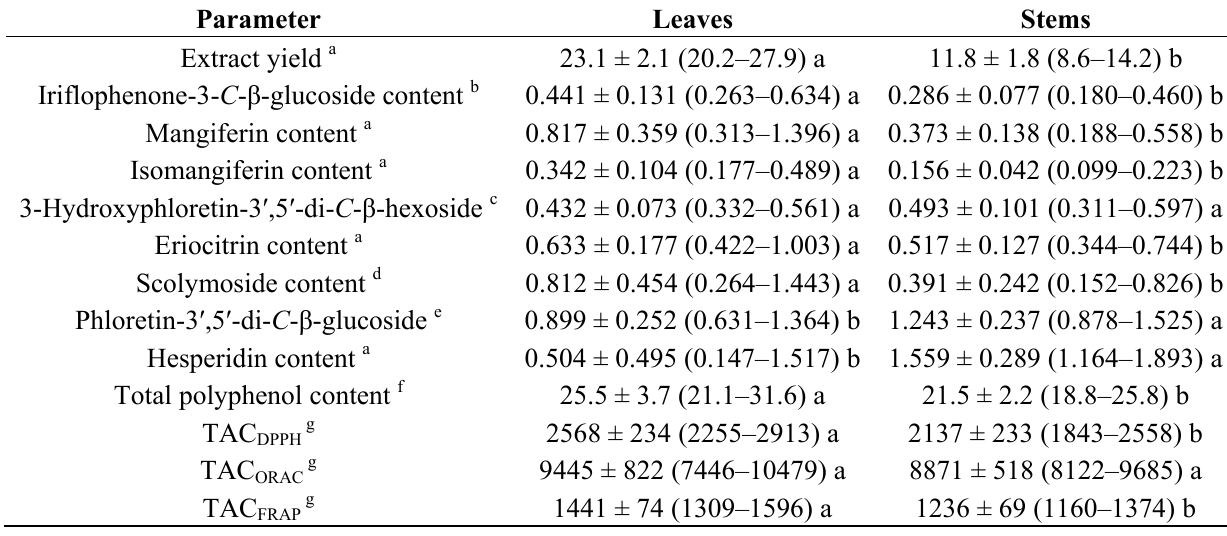
Table 6. Extract yield, phenolic composition and total antioxidant capacity (TAC) of freeze-dried aqueous extracts of green Cyclopia subternata leaves (n = 10) and stems (n = 10). Parameter Leaves Stems Extract yield